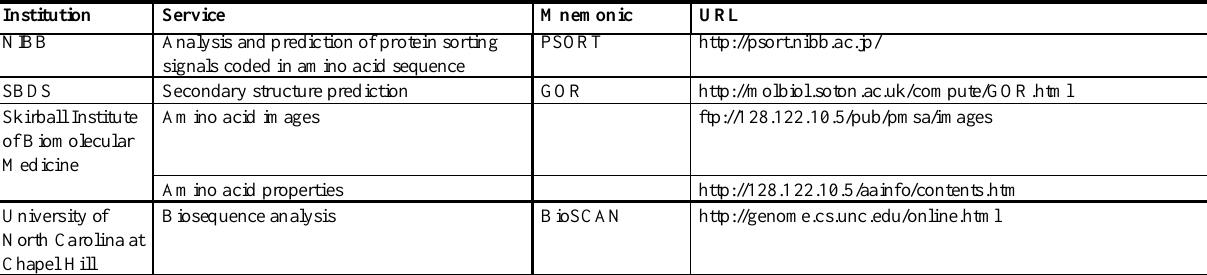
Table 2 - Analysis and search online